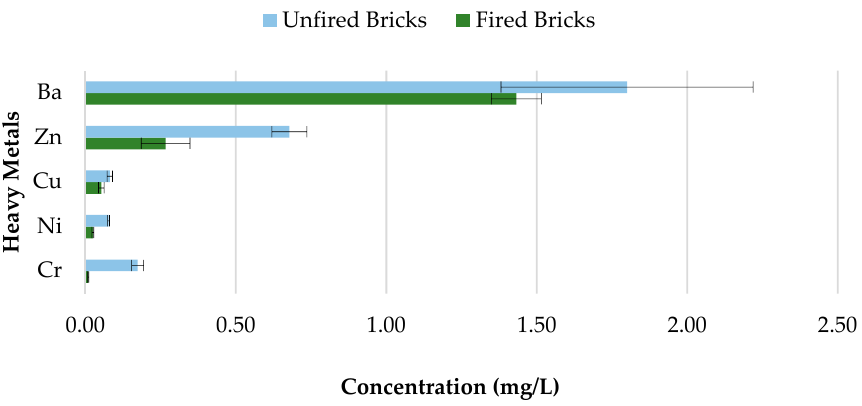
Materials 2020 , 13 , x FOR PEER REVIEW Figure 19. Heavy metal concentration of 1% CB content bricks before and after firing. Figure 19. Heavy metal concentration of 1% CB content bricks before and after firing. Figure 19. Heavy metal concentration of 1% CB content bricks before and after firing.